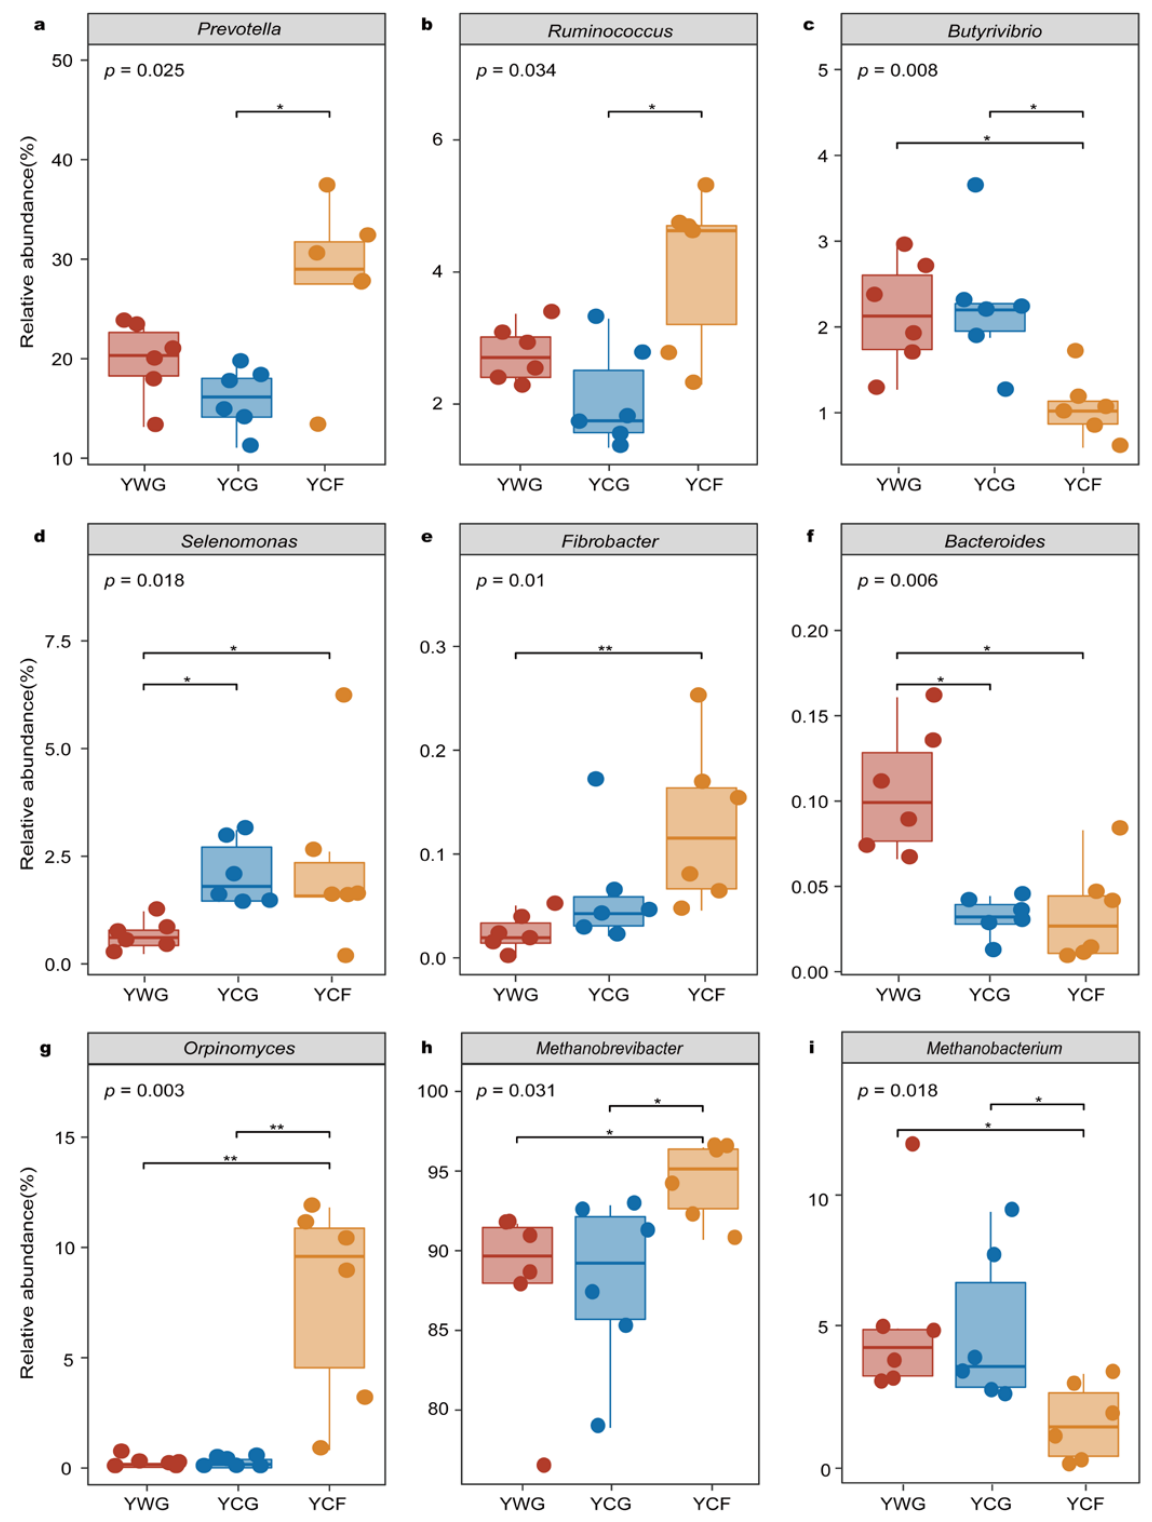
Figure 5. Relative abundance of putative functional bacteria ( a – f ), fungi ( g ), and archaea ( h , i ) by rumen microbiota compartment and GHG emissions phenotype of yaks. YWG, Warm-season grazing, YWG: Warm-season grazing, YCG: Cold-season grazing, YCF: Cold-season indoor feeding. * p < 0.05, ** p < 0.01 (Wilcoxon rank-sum